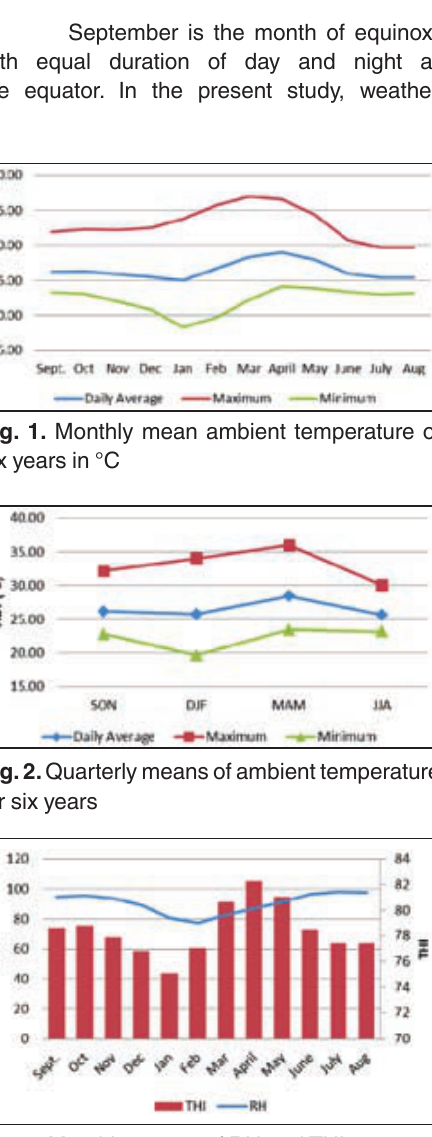
Fig. 3. Monthly means of RH